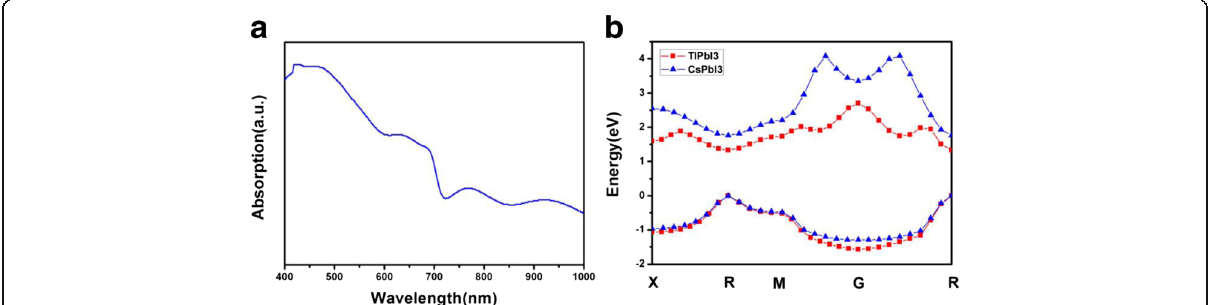
Fig. 3 a is the absorption spectrum of CsPbI 3 measured by experiment. b is the structures of valence-band maximum and conduction-band mini- mum of